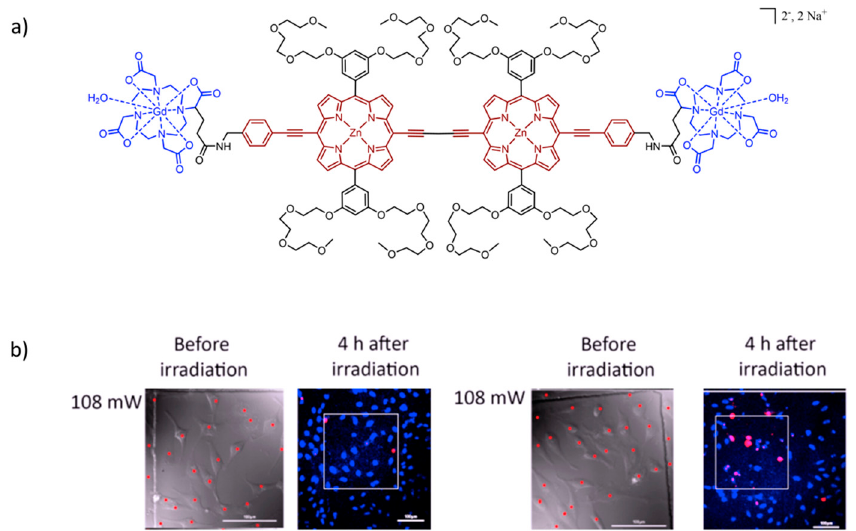
Figure 6. ( a ) Structure of the zinc porphyrin dimer linked to two GdDOTA complexes; ( b ) phototoxicity induced by a two-photon excitation at 910 nm after 24 h incubation in the absence (left) or presence (right) of the compound. Scale bar is 100 µ m. Adapted with permission from [55]. Copyright 2018 American Chemical Society.